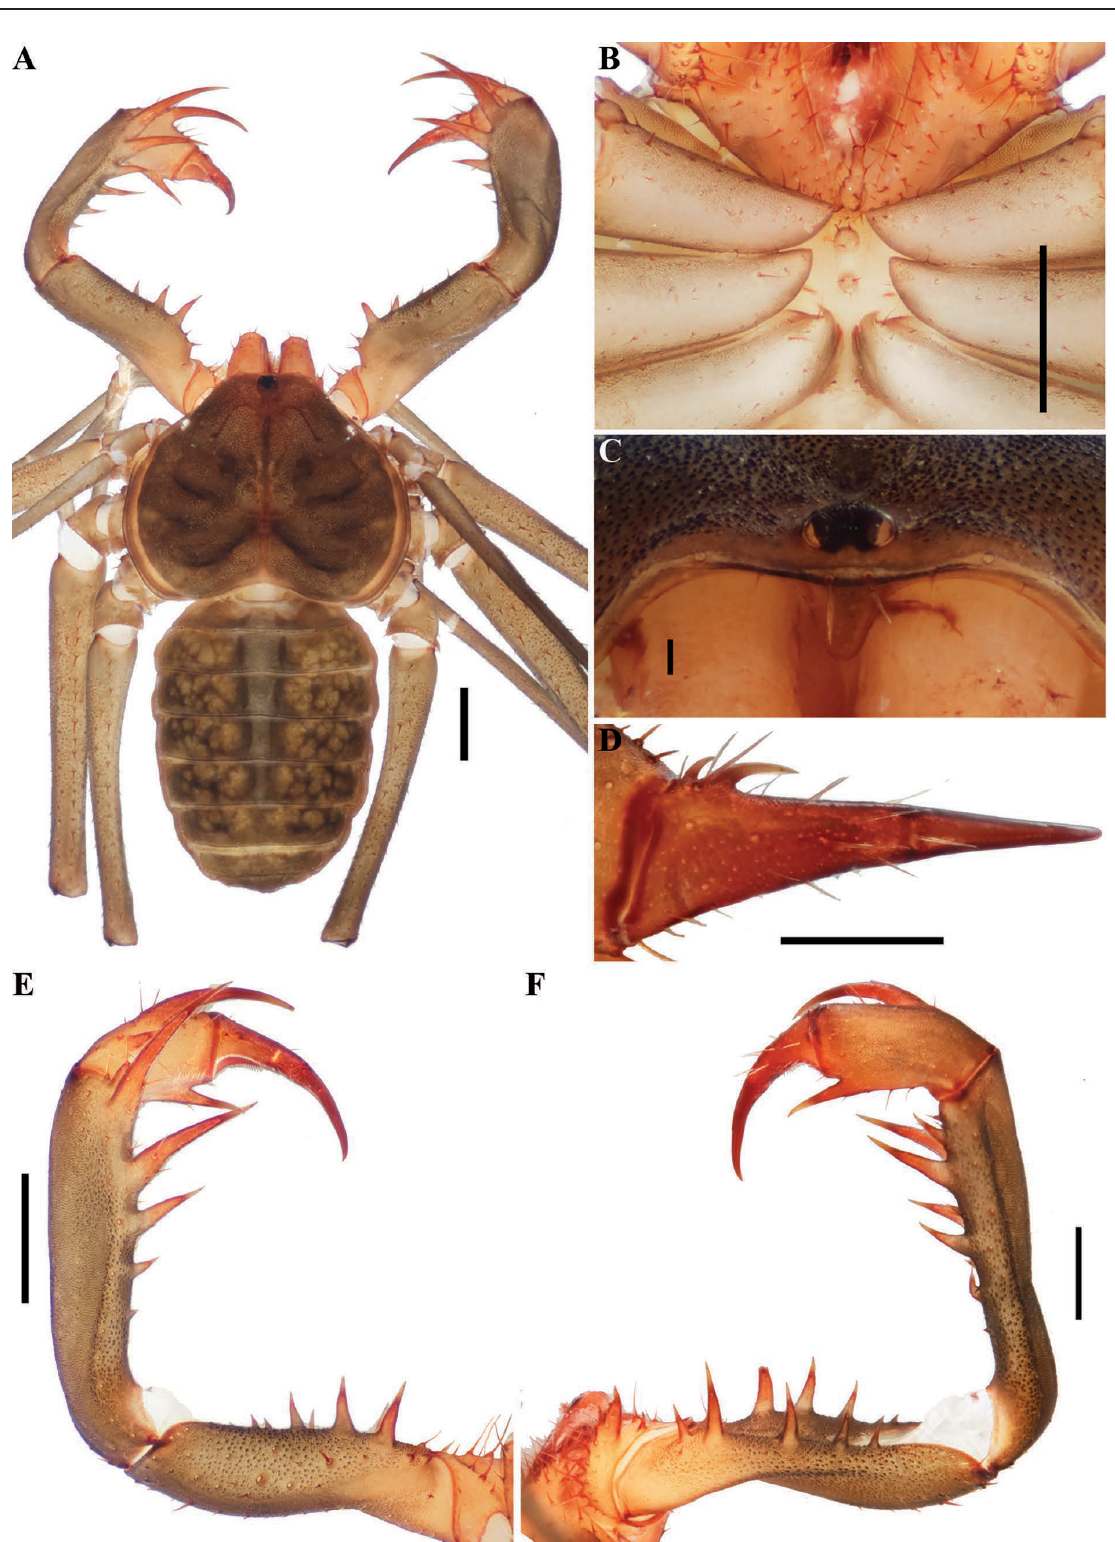
Fig. 145. Sarax seychellarum (Kraepelin, 1898) comb. nov. (AMCC [LP 9075]), general morphology, ♀. A . Carapace, dorsal view. B . Sternum, ventral view. C . Frontal process. D . Pedipalp tarsus, frontal view. E . Pedipalp, dorsal view. F . Pedipalp, ventral view. Scale bars: A–B, E–F = 1 mm; C = 0.1 mm; D = 0.5